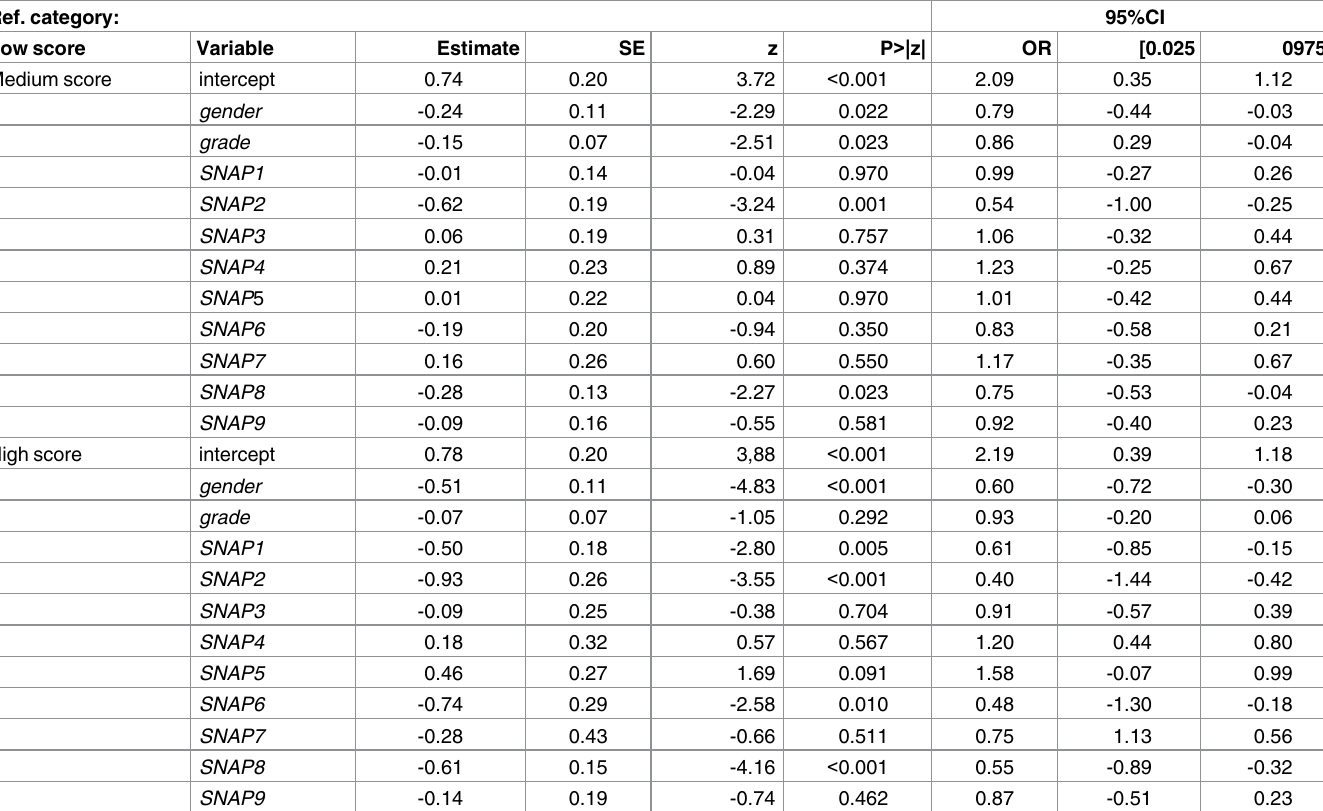
Table 3. Multinomial logistic regression model. Ref.